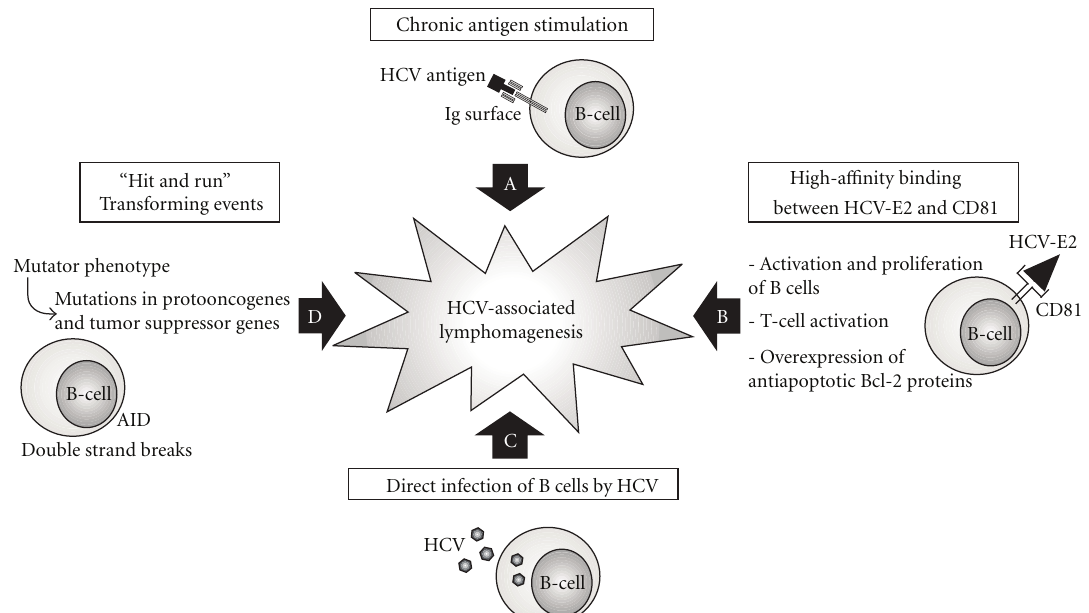
Figure 1: (A–D) The di ff erent oncogenetic mechanisms are not mutually exclusive, but they may be integrated and cooperate in a multifactorial pathogenetic model of HCV-associated B-cell